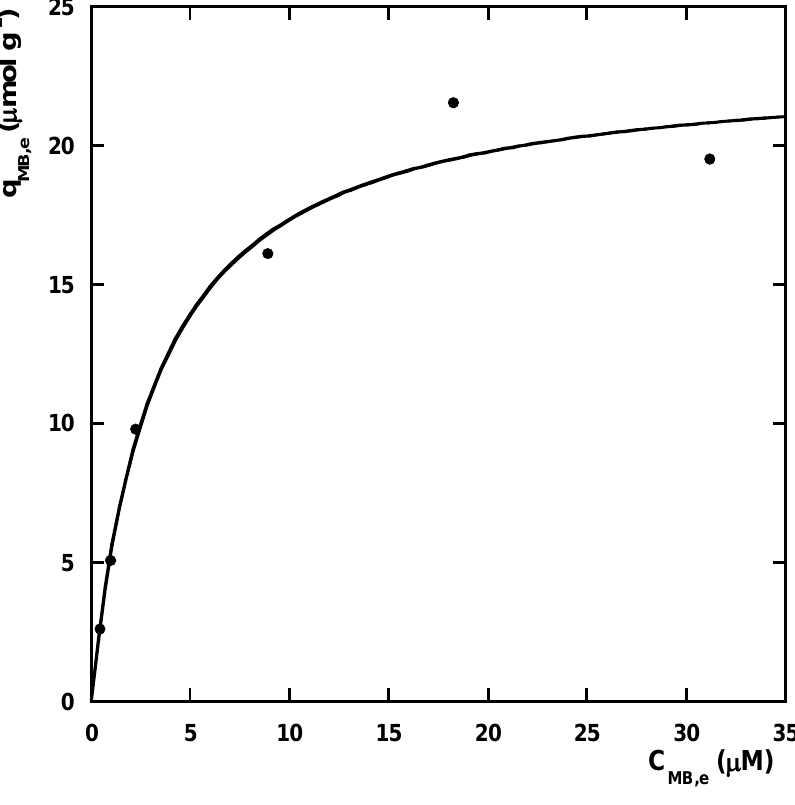
Figure 4. Adsorption isotherm of MB onto MnO 2 .